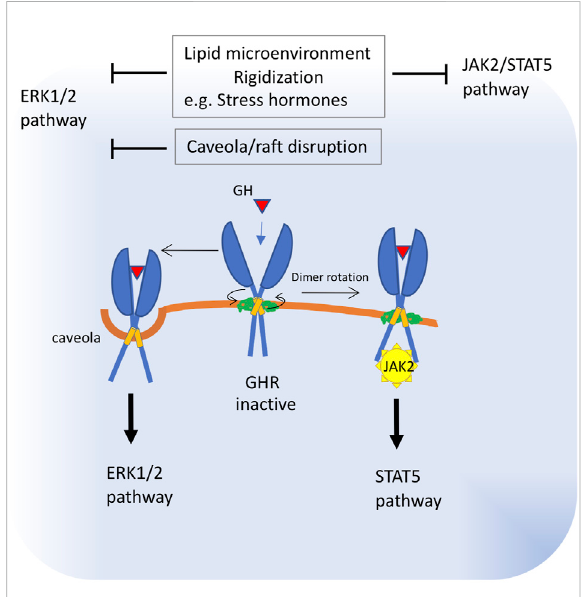
FIGURE 3 Proposedalterationsingrowthhormonereceptorfunctionin old membranes. The transmembrane region of GHR can adopt twoalternativedimericstructures thatcorrespondtodormantand active receptor states. Binding of the hormone realigns the GHR subunits by rotation and closer apposition. These structures interchange via allosteric rearrangements of transmembrane helices and juxtamembrane regions, which are in fl uenced by protein-lipid interactions. Once activated, GHR signals are transduced via the cytoplasmic receptor-associated protein tyrosine kinase, Janus kinase 2 (JAK2) and downstream STAT5. A fraction of the GHR population is localized in caveolin-cholesterol enriched membranes and signals preferentially through downstream ERK. These data strongly suggest that GH signaling is in fl uenced by the membrane localization or lipid environment of the GHR receptor. Thus, impaired subunit rotation due to membranerigidization or increased membraneviscosity will block JAK2 signaling, whereas caveola disruption will impact ERK1/ 2 signaling. Increased viscosity of plasma membrane was described as a consequence of raised levels of stress